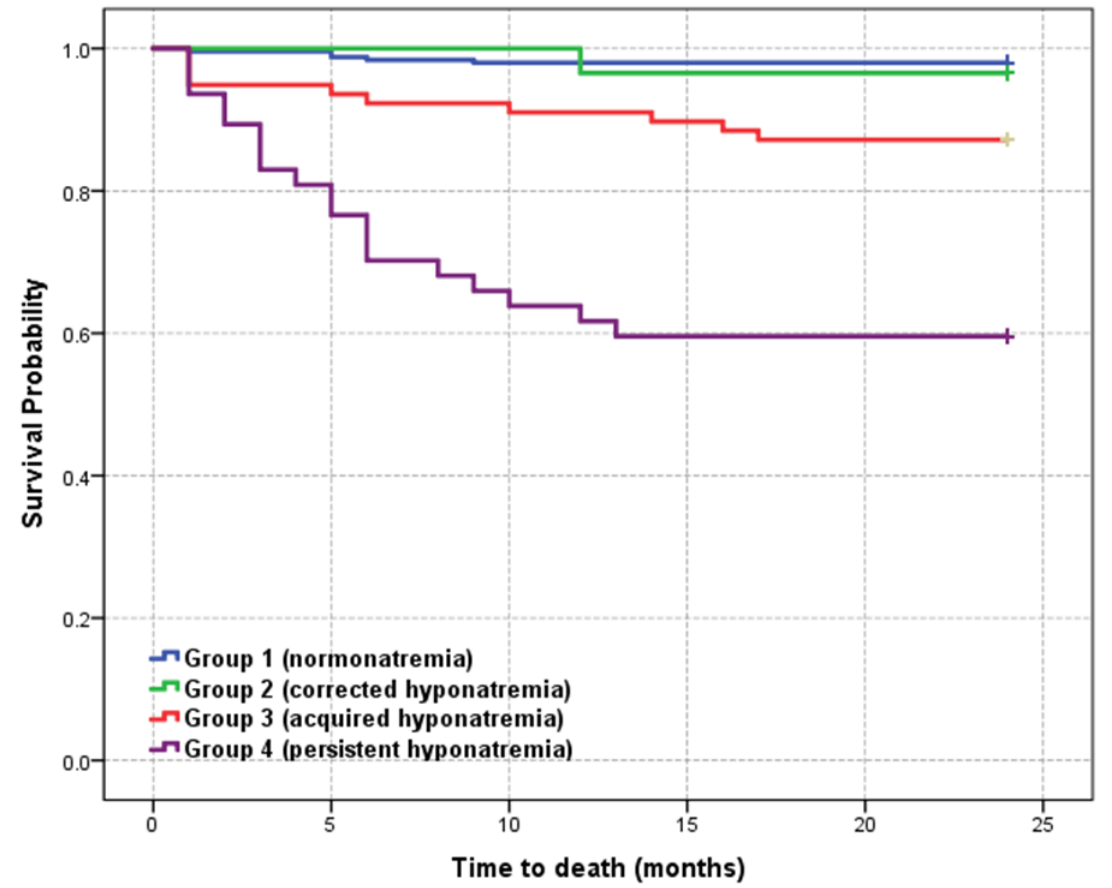
Figure 1. Kaplan–Meier survival curve of the study cohort according to serum sodium levels.